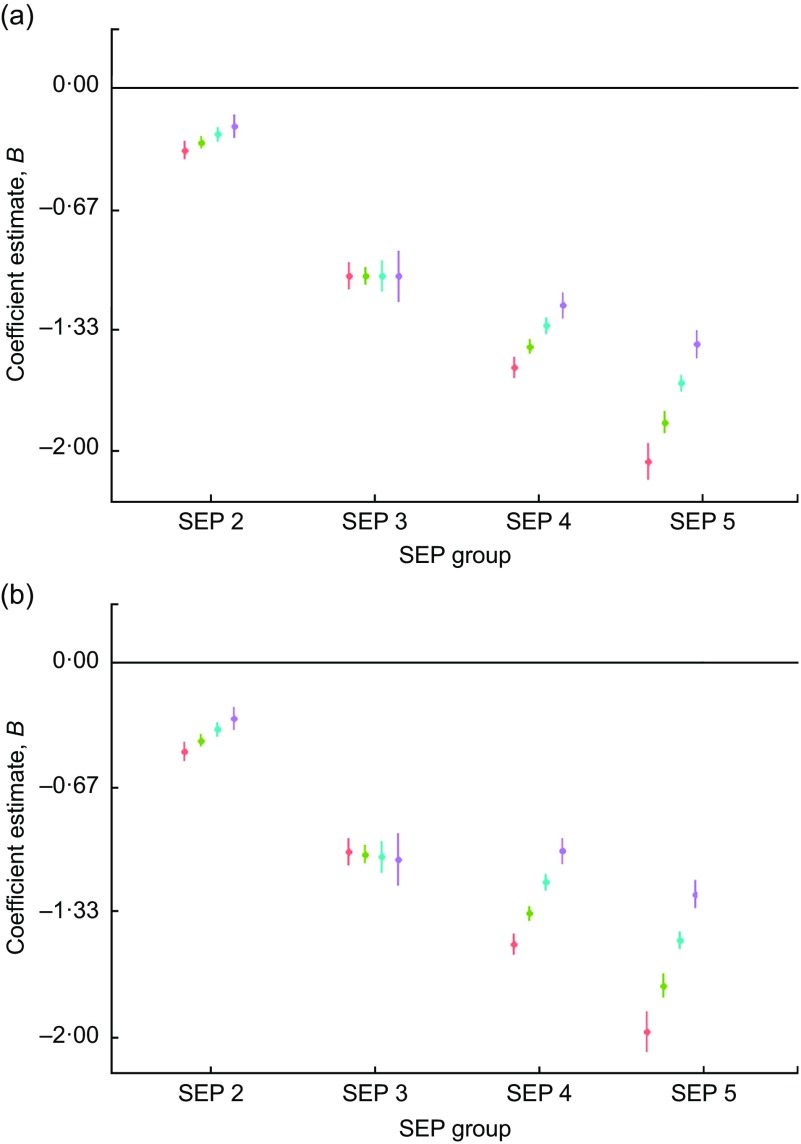
Regression estimates of (a) male and (b) female height size Z-scores (dots) with 95 % CI (whiskers) across socio-economic position (SEP) groups (2–5), with SEP 1 as reference group (horizontal line at 0), by decade of birth centred on 1960 (), 1970 (), 1980 () and 1990 (), for children and adolescents (n 40 484) aged 3–19 years of Ladino and Maya ancestry born during 1955–1993 in Guatemala (n
observations 157 067). The plots were created using R packages ggplot2, broom, jtools, dotwhisker and dplyr (see the online supplementary material for references)